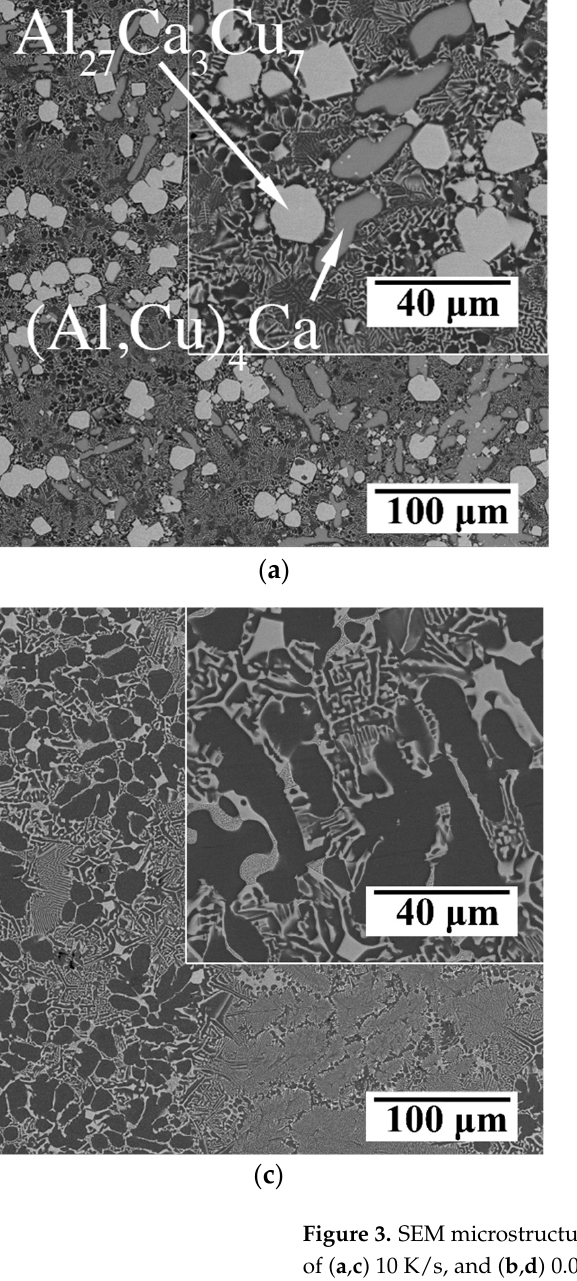
Figure 4. XRD data for (1) Al5.6Cu3.5Ca, (2) Al14Cu2.5Ca and (3) Al18Cu6Ca alloys. CoK α radia- tion. The Al30Cu1.0Ca and Al36Cu1.0Ca alloys were analyzed in order to clarify the pri- mary crystallization area boundaries of another ternary Al 8 CaCu 4 compound that is in equilibrium with the aluminum in this system. The microstructure of both alloys contains bright primary crystals (Figure 5a,b) which, according to the spectral analysis (Table 2), has an excess of copper as compared to the Ca-containing phases considered above. The chemical composition of these crystals obtained after slow solidification is somewhat dif- ferent from that obtained after accelerated solidification. The latter fact can be coupled with the relatively fine structure of the crystals obtained after solidification, which pre- vents accurate measurements. Thus, according to the data for the slowly solidified alloy, the observed primary crystals correspond perfectly well to the Al 8 CaCu 4 phase [25]. One can also note that the slow solidification of the Al36Cu1.0Ca alloy (Figure 5c) also revealed